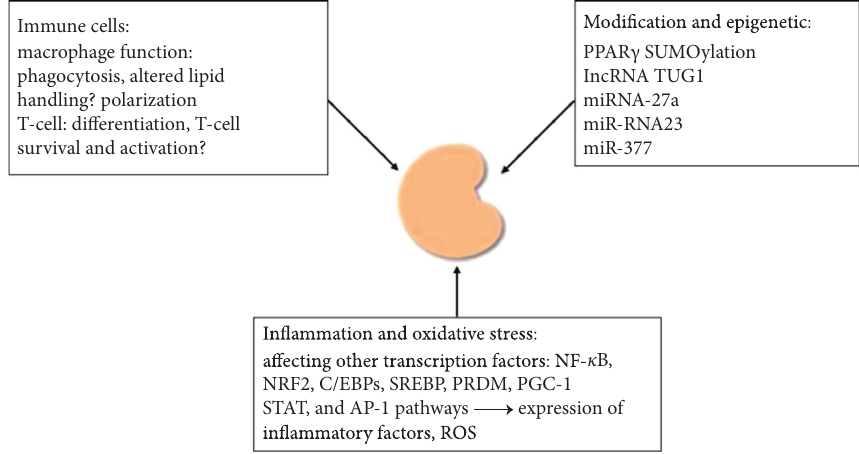
Figure 2: Indirect renal-protective